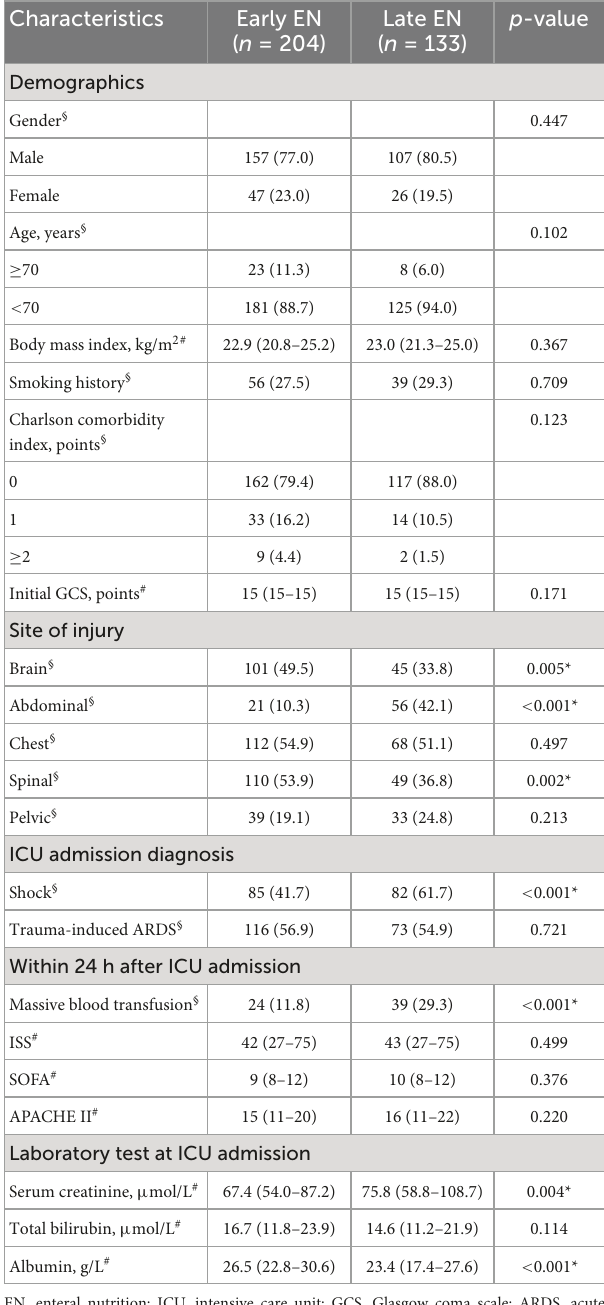
TABLE 1 Baseline characteristics of the severe trauma patients receiving invasive mechanical